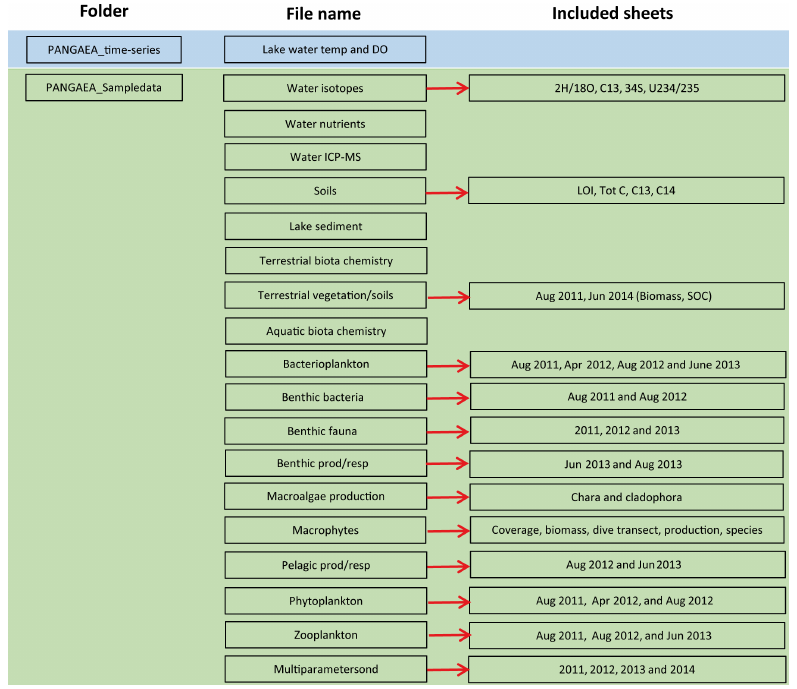
Figure 14. Illustration of folders, resulting data tables and associated sheets in the PANGAEA